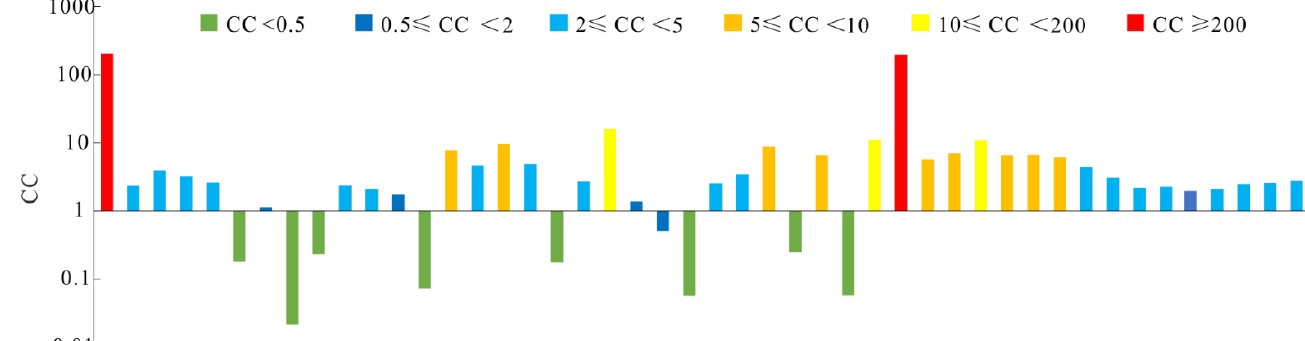
Figure 6. Concentration coefficient (CC) of trace elements in the sample Y1 from southern Shanxi Province. Data of UCC are from Taylor and McLenan (1985) [24]. CC represent ratio of elemental content in investigated bauxite vs. the UCC. Light REEs (LREE-La, Ce, Pr, Nd, and Sm), Medium REEs (MREE-Eu, Gd, Tb, and Dy), and Heavy REEs (HREE-Ho, Er, Tm, Yb, and Lu).